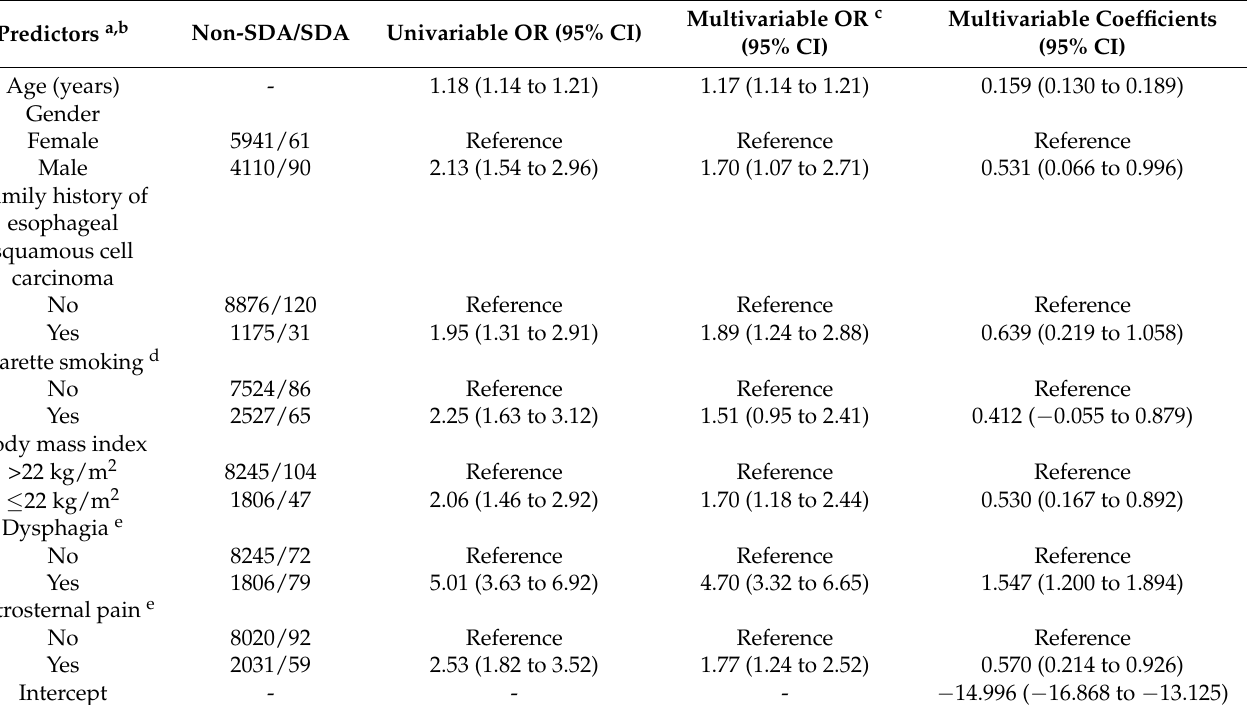
Table 2. Predictors and regression coefficients of the prediction model for severe dysplasia and above (SDA) generated from the development